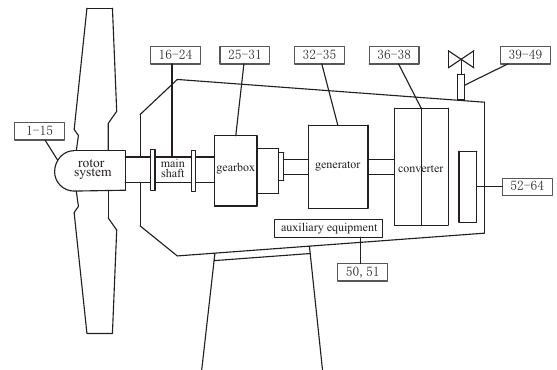
Figure 7. Sensor structure of WT.